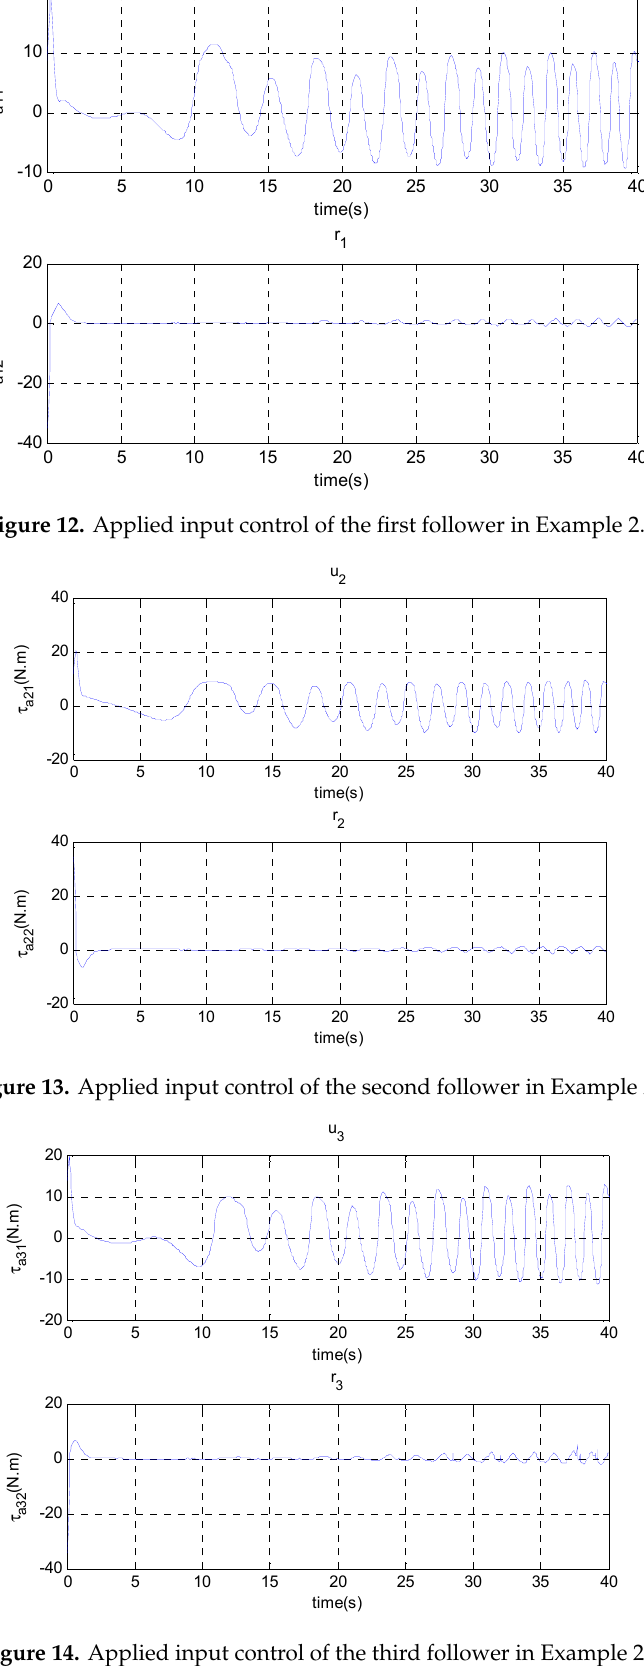
Figure 15. Applied input control of the fourth follower in Example 2.